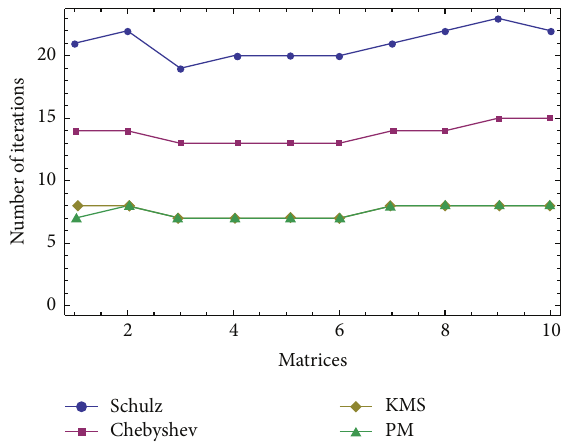
Figure 1: Comparison of the number of iterations for solving Example